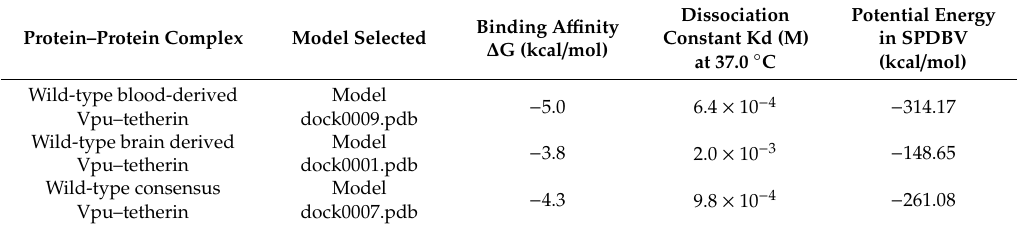
Table 4. Presentation of binding a ffi nity and dissociation constant (Kd) calculated from PROtein binDIng enerGY prediction (PRODIGY) and potential energy computed in SPDBV for Vpu–tetherin